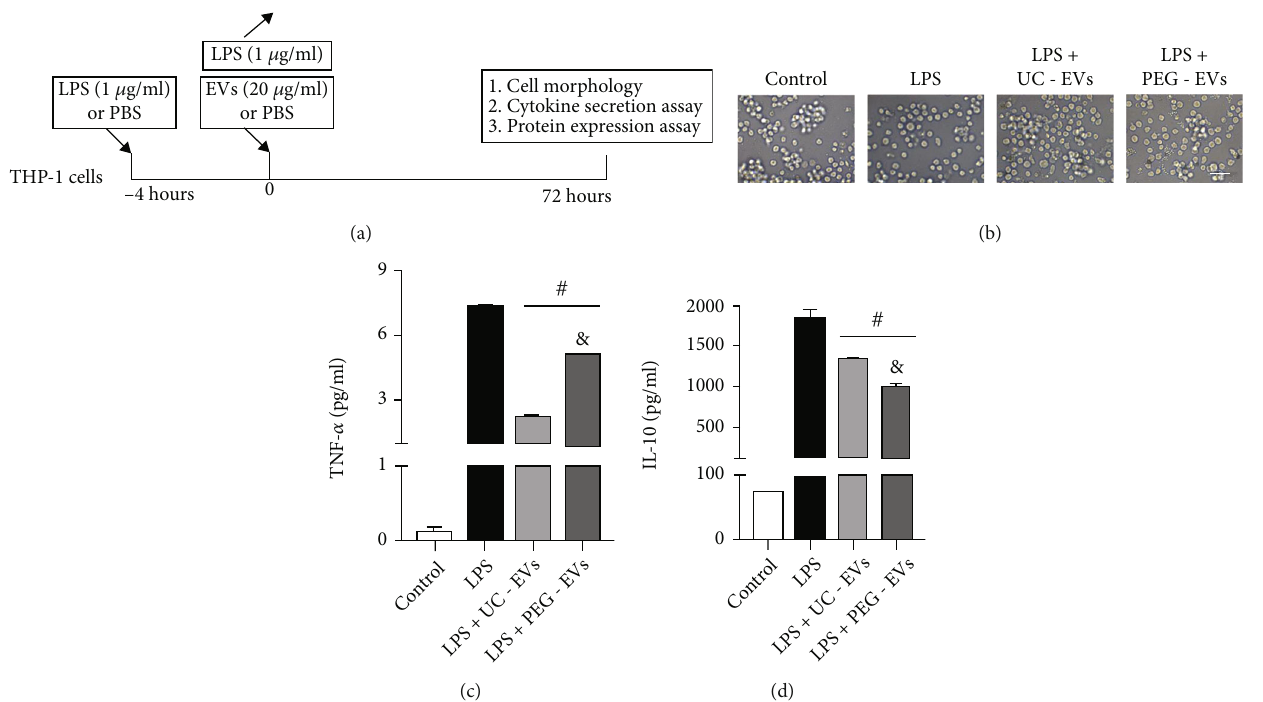
Figure 4: Comparison of EV biological e ff ects on LPS induction of THP-1 cells. (a) Schematic representation of the EV cellular e ff ect assay on the cell model of THP-1 cells treated with LPS. (b) The indicated cell morphology of THP-1 cells treated with LPS and EV; scalebar = 50 μ m . Statistical analysis of (c) TNF- α and (d) IL-10 secretion indicated a signi fi cant reduction by EV treatment compared with the LPS group ( # compared with the LPS group and P < 0 : 05 ) and a di ff erence in the comparison of UC-EVs and PEG-EVs ( & compared with the LPS + UC-EVs group and P < 0 : 05